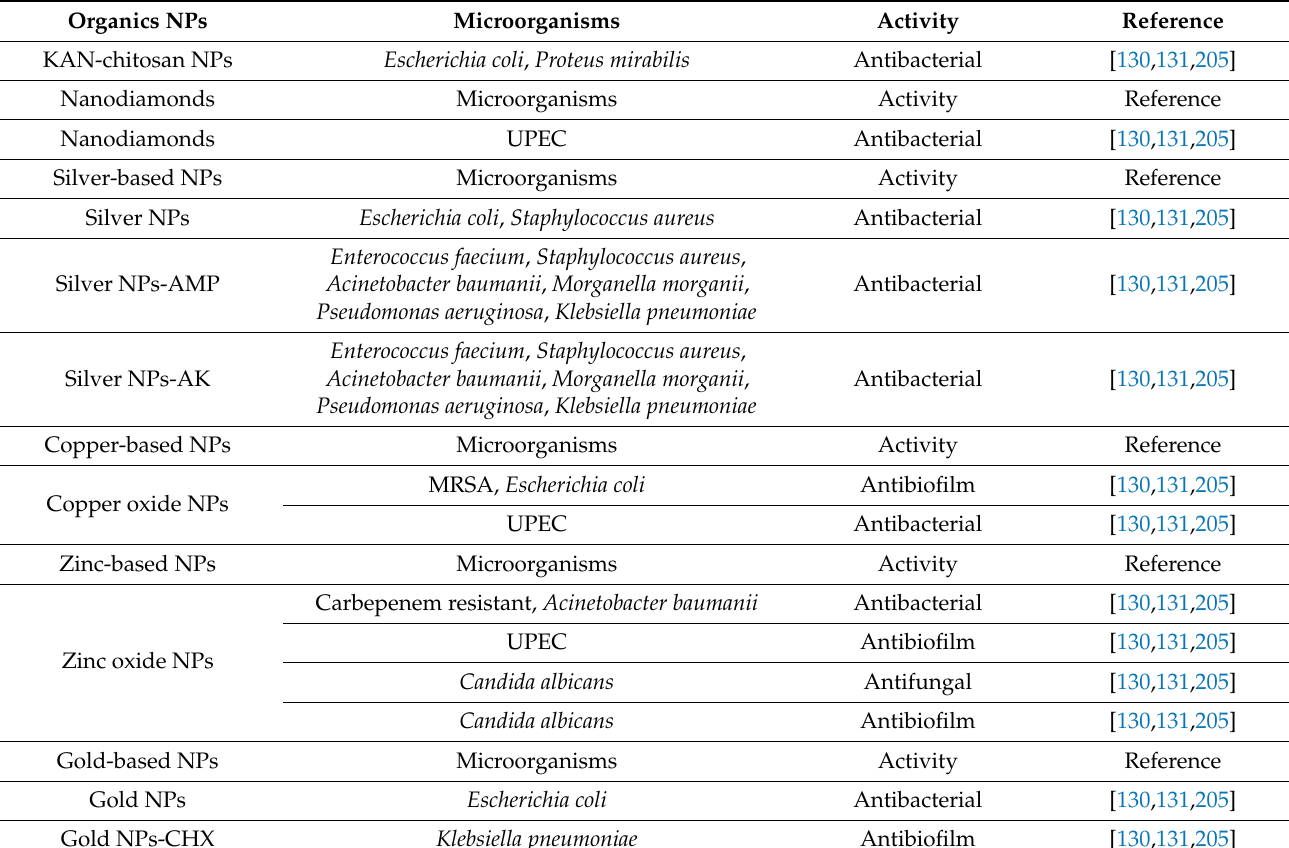
Table 1. Specific NPs approaches for treating